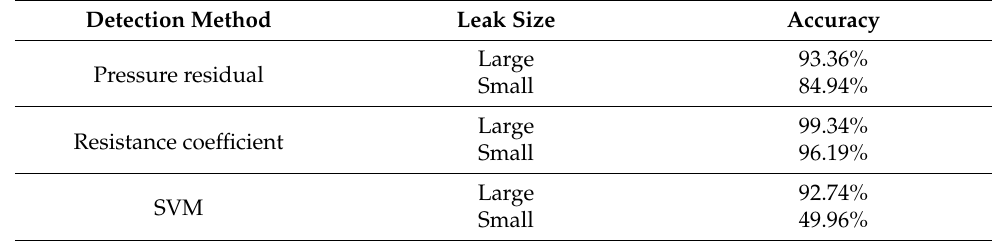
Figure 9. Residuals of resistance coefficients between the inlet and outlet of the pipeline when leakage occurred. ( a ) Large leakage; ( b ) small leakage. Table 2. Comparison of leak-detection accuracy of various methods.